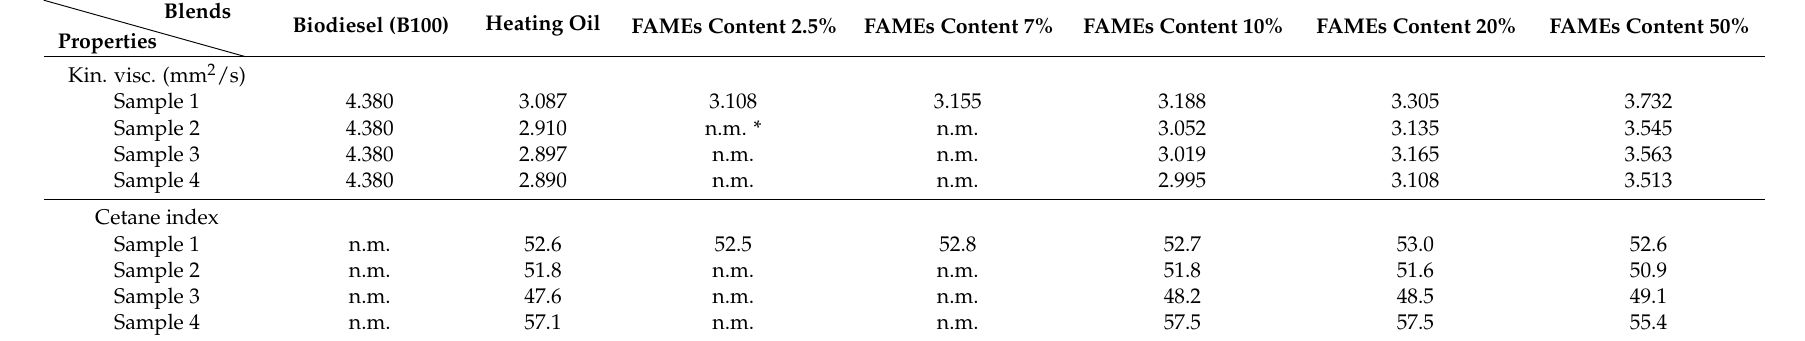
Table 3. Kinematic viscosity and cetane index of oil